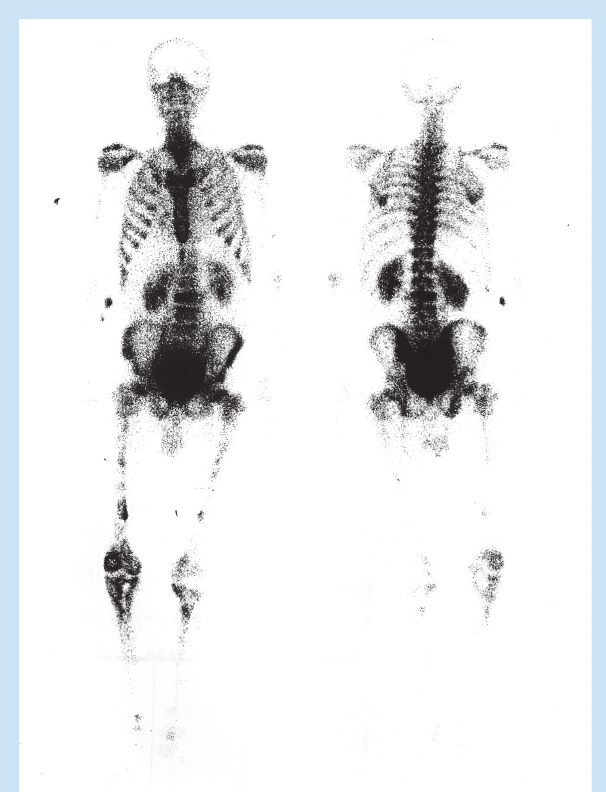
Fig. 2b. Whole-body bone scintigraphy and tomography. Osteoblastic lesions in both femurs and third lumbar